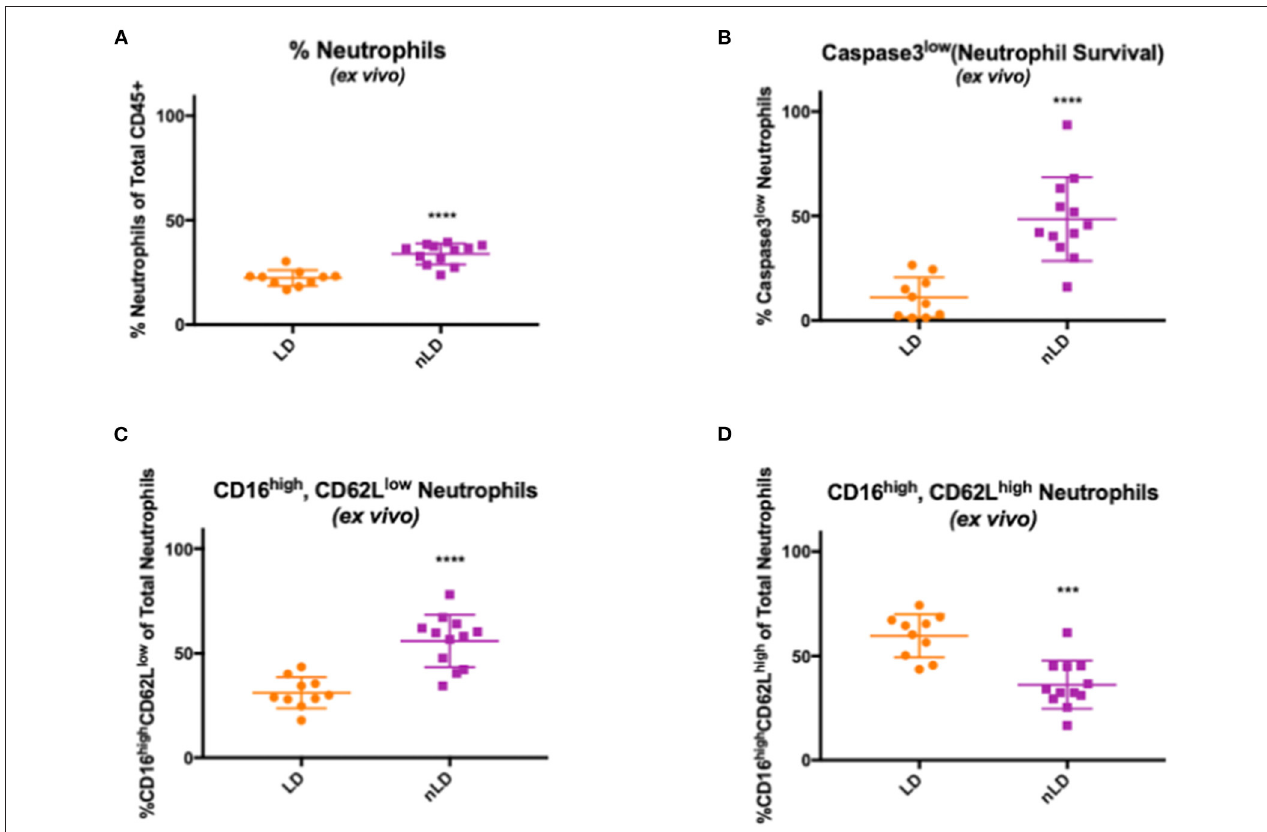
FIGURE 2 | Effects of vaginal bacteria from cervico-vaginal cytobrushes on neutrophil frequency and phenotype. Neutrophils frequency in cervico-vaginal cytobrushes obtained from 22 women divided in two groups according to the vaginal bacterial composition: Lactobacillus dominant (LD, n = 10 women) and non- Lactobacillus dominant (nLD, n = 12 women) (A) Higher frequency of total neutrophils in nLD compared to LD as a percentage of total CD45 + leukocytes in vaginal cytobrushes measured by flow cytometry ( p < 0.0001). (B) Higher frequency of active Caspase-3low neutrophils in nLD compared to LD as a percentage of total neutrophils in vaginal cytobrushes measured by flow cytometry ( p < 0.0001). (C) CD16high, CD62Llow neutrophils in nLD compared to LD as a percentage of total neutrophils in vaginal cytobrushes measured by flow cytometry ( p < 0.0001). (D) Lower frequency of CD16high, CD62Lhigh neutrophils in nLD compared to LD as a percentage of total neutrophils in vaginal cytobrushes measured by flow cytometry ( p = 0.0002). In (A–C) “****” represents p -values < 0.0001, in (D) “***” represents p -value = 0.0002. Statistical differences in neutrophil frequencies between nLD and LD samples were determined by Mann-Whitney test with a p -value < 0.05 considered significant. Lines represent mean and